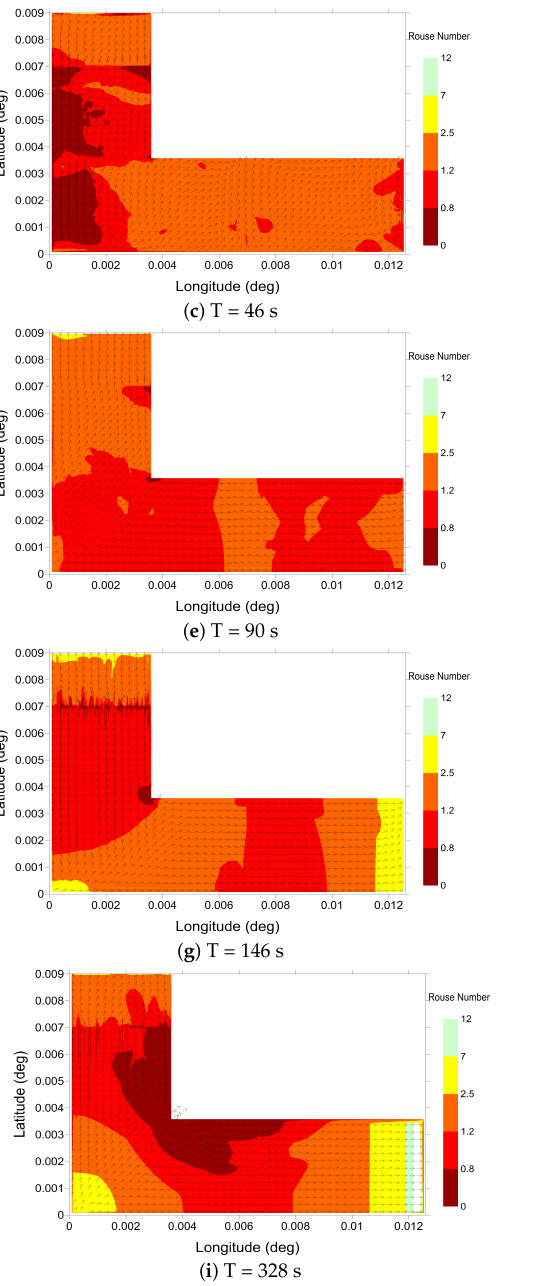
Figure 6. The spatial distribution of the minimum Rouse number computed by the simulation of the sinusoidal line crest long wave with a 1-m wave amplitude with T = 16 s, T = 46 s, T = 90 s, T = 146 s, T = 328 s for LA/LB = 0.8 in the left column and LA/LB = 1 in the right column ( a – j ), respectively. The maximum velocity vectors are also shown for each